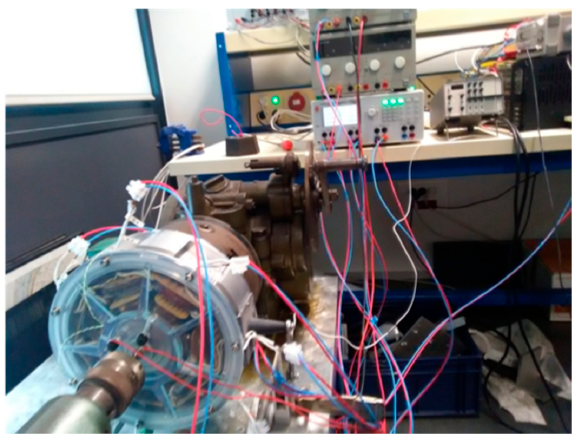
Figure 13. Set-up test band for measuring the static torque.